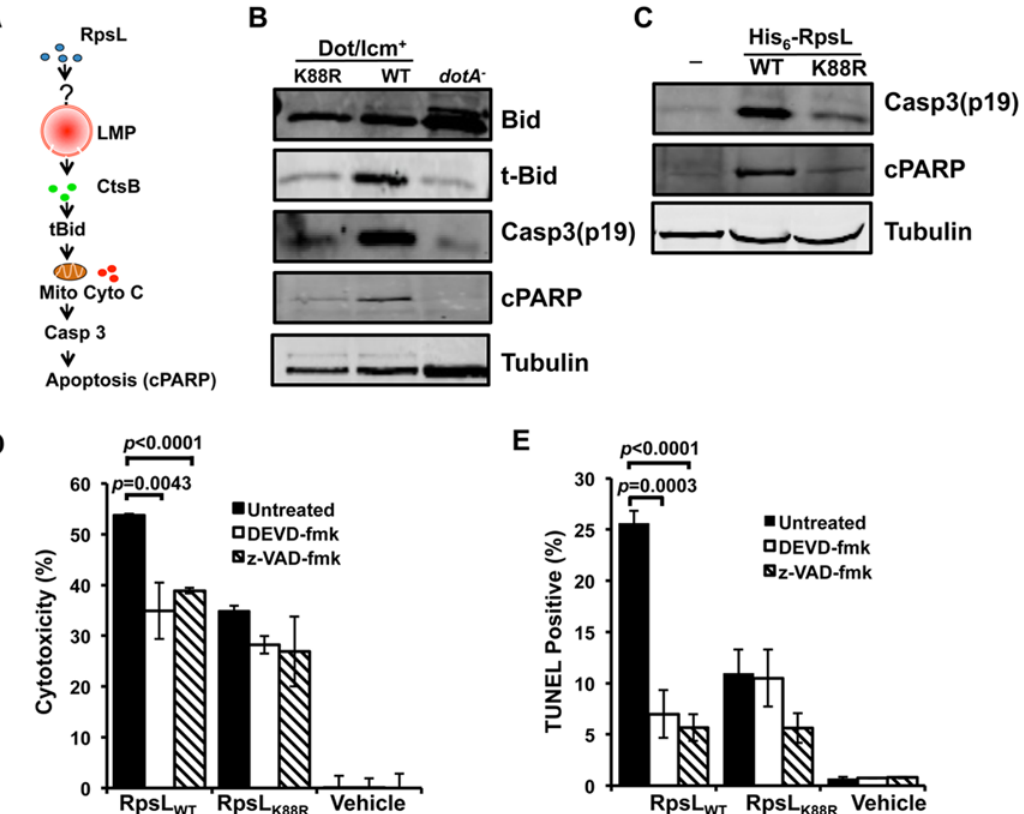
Fig 7. The classic apoptosis pathway is involved in the cell death induced by RpsL. A . A model for one of the possible cascades activated by RpsL that leads to macrophage death. Refer to the main text for details. B – C . The processing of apoptotic proteins by RpsL. BMDMs were infected with relevant bacterial strains with an MOI of 1 ( B ) or transfected with purified proteins ( C ) for 8 and 6 hrs, respectively. Samples were processed for immunoblot with specific antibodies. Tubulin was probed as a loading control. Similar results were obtained in at least two independent experiments. D-E . RpsL-induced macrophage death involves caspase activation. BMDMs from A/J mice were treated with 20- μ M DEVD-fmk (against caspase-3), 20- μ M z-VAD (against multiple caspases) or the solvent DMSO for 90 minutes before protein transfection. Six hours post protein transfection, LDH release ( D ) was determined or the samples were processed for TUNEL staining ( E ). Vehicle, transfection reagent